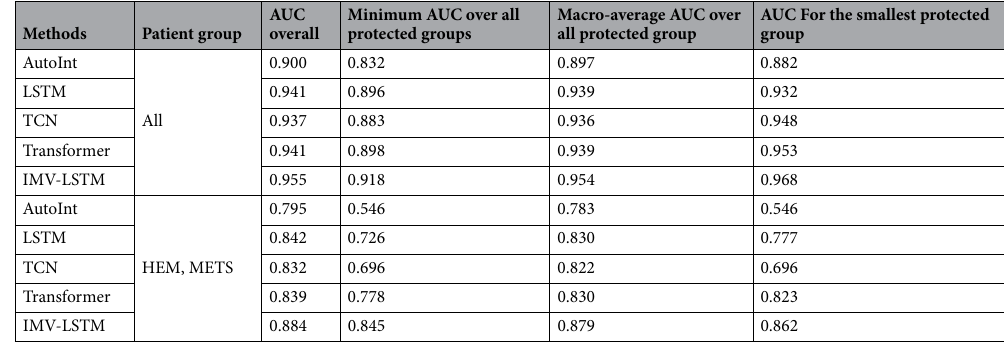
Table 7. Summarized Area under the curve (AUC) performance of the in-hospital mortality predictors evaluated on sets of protected groups. Higher AUC indicates better predictive